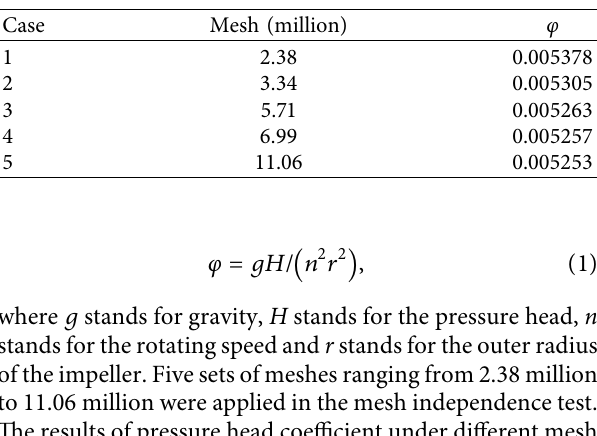
Table 2: Mesh independence